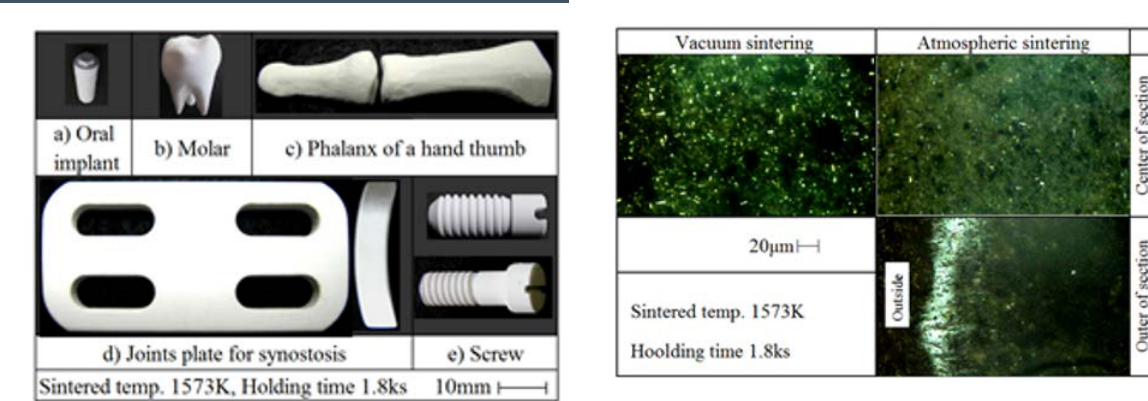
into various shapes. The surface roughness of the TMA vacuum-sintered bodies became smooth: Ra